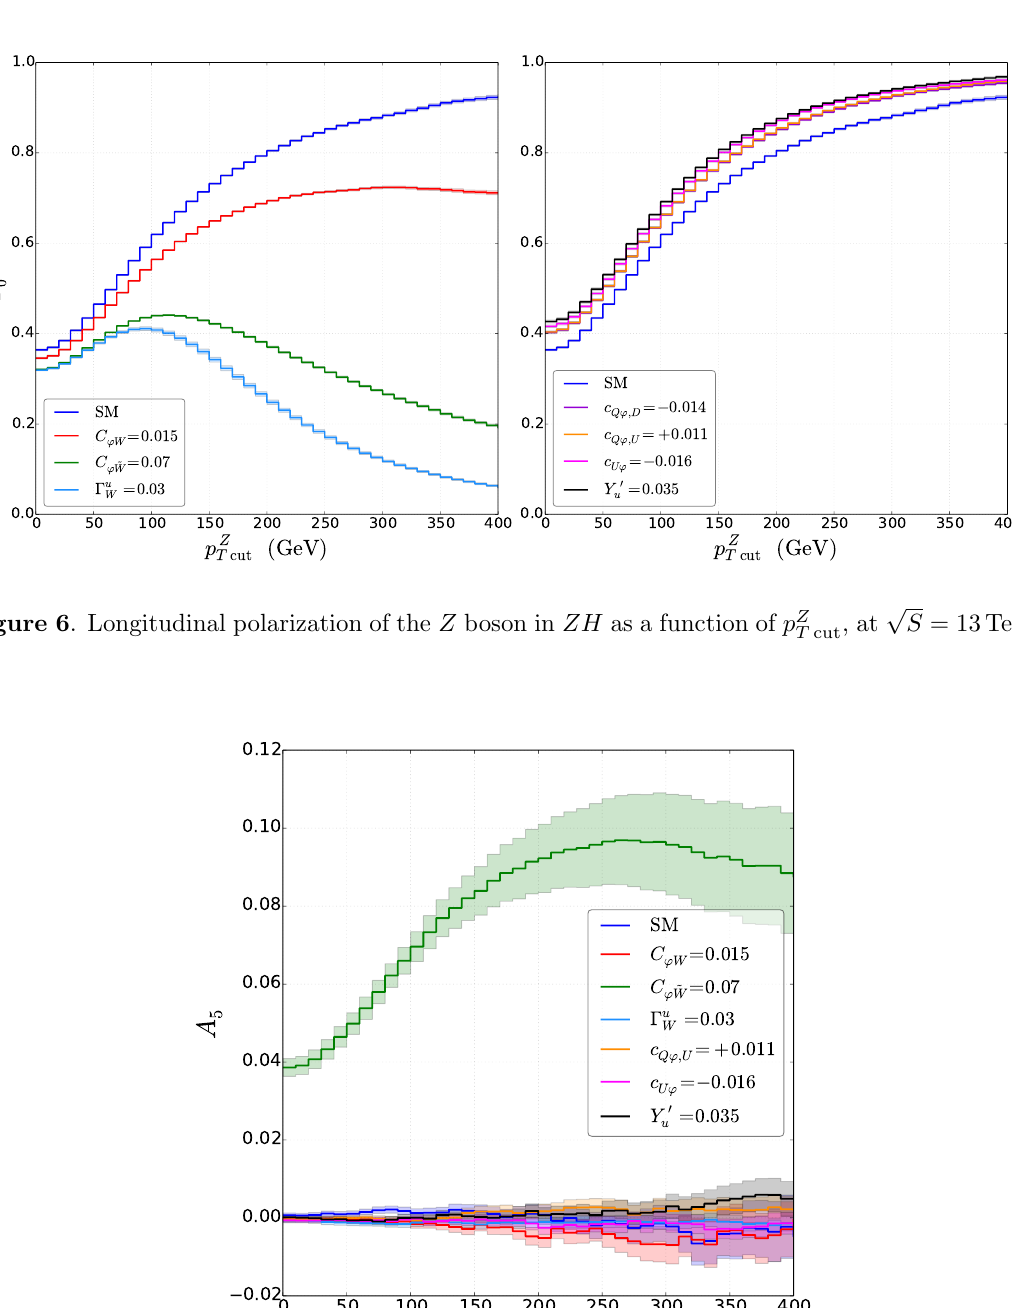
Figure 7 . Angular coe(cid:14)cient A 5 as a function of p Z